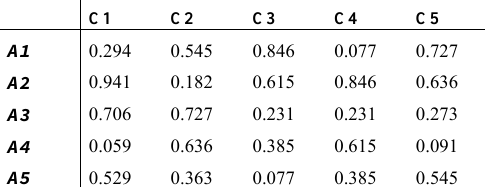
Table 5.1. Alternatives performance values with respect to problem’s criteria